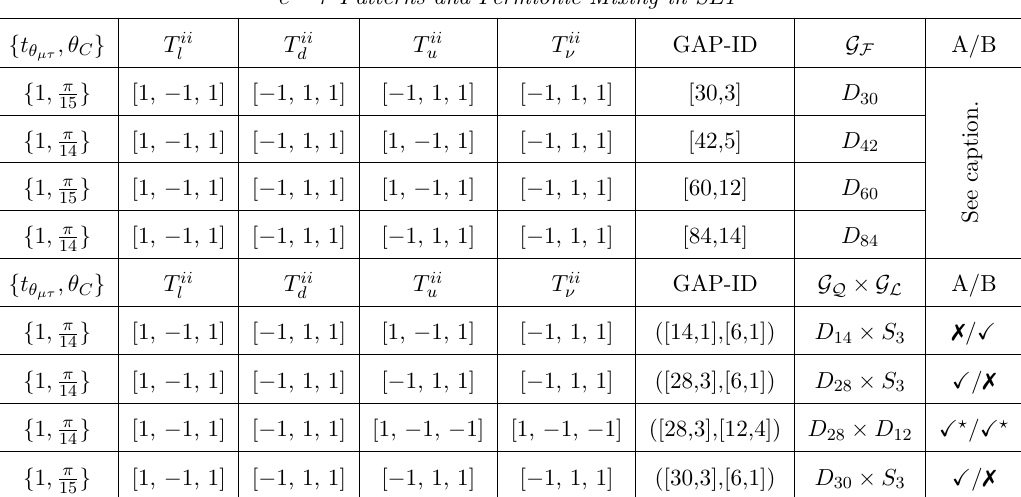
Table 5 . The same as table 4, but for (cid:21) [ e(cid:28)X ] . For G F , D 30 is only found for Pattern A, and D 42 dl is only found for Pattern B. The same is respectively true for D 84 and D 60 when considering (cid:1) ( (cid:22) ) but both are found in both patterns for (cid:1) (cid:22) (we show triplet phases). The X ? notation implies that 1 this group is only found for (cid:1) (cid:22) , and the phases correspond to Pattern 1